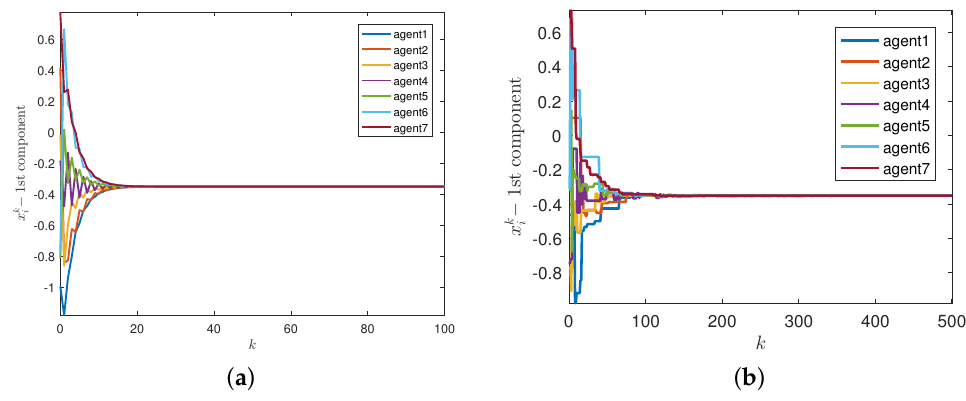
Figure 2. Convergence results of the two algorithms. ( a ) Algorithm 1. ( b ) Algorithm 2.